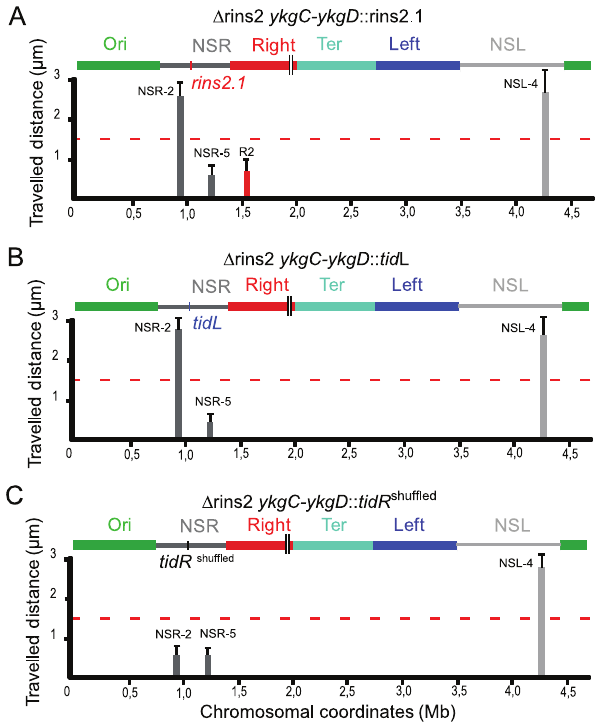
Figure 4. tid R and tid L insulate the Ter MD. Travelled distance of different markers in strains with a D rins2 deletion, and carrying segment rins2.1, tid L or a control sequence in the middle of the NS Right region. The representation is the same as in Figure 2. (A) strain D rins2 ykgC- ykgD::rins2.1 with a deletion of the segment rins2 and an insertion of segment rins2.1 between ykgC and ykgD (markers NSR-2, NSR-5, Right-2 (R2), NSL-4 are indicated from left to right). (B) strain D rins2 ykgC- ykgD :: tid L with a deletion of the segment rins2 and insertion of tid L between ykgC and ykgD (markers NSR-2, NSR-5 and NSL-4 are indicated from left to right). (C) strain D rins2 ykgC-ykgD :: tid R shuffled with a deletion of the segment rins2 and an insertion of shuffled sequence with a similar palindromic organization as tid R between ykgC and ykgD (markers NSR-2, NSR-5, NSL-4 are indicated from left to right).